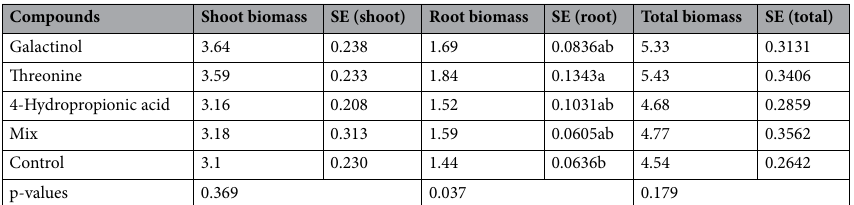
Compounds Shoot biomass SE (shoot) Root biomass SE (root) Total biomass SE (total)